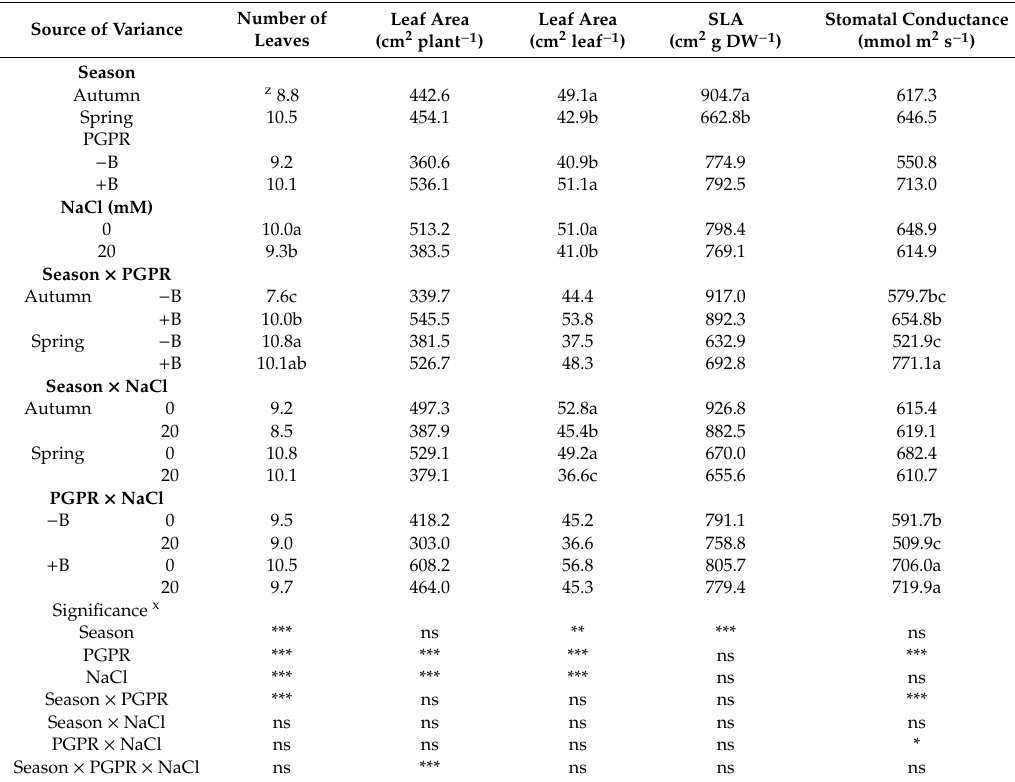
Table 3. Leaf characteristics of leaf lettuce plants grown during autumn and spring in nutrient solutions containing di ff erent levels of NaCl and bacterial biostimulant.